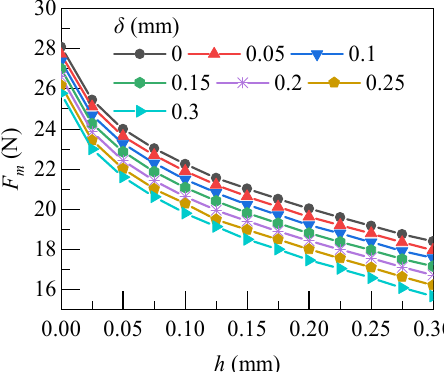
10 of 16 Table 3. Variation range of key structural parameters. Parameter